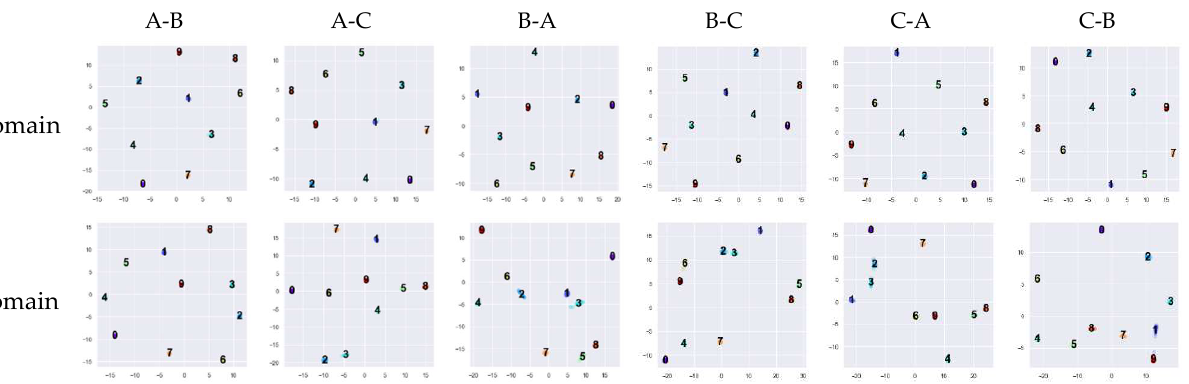
Figure 12. Feature visualization via t-SNE in cross-domain tasks.